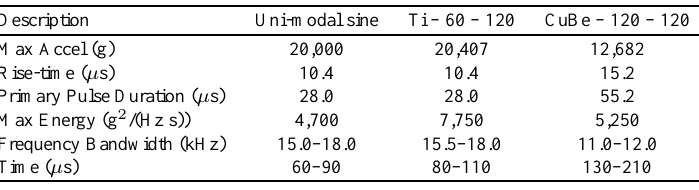
Table 2 Signal parameters for the representative acceleration signal traces